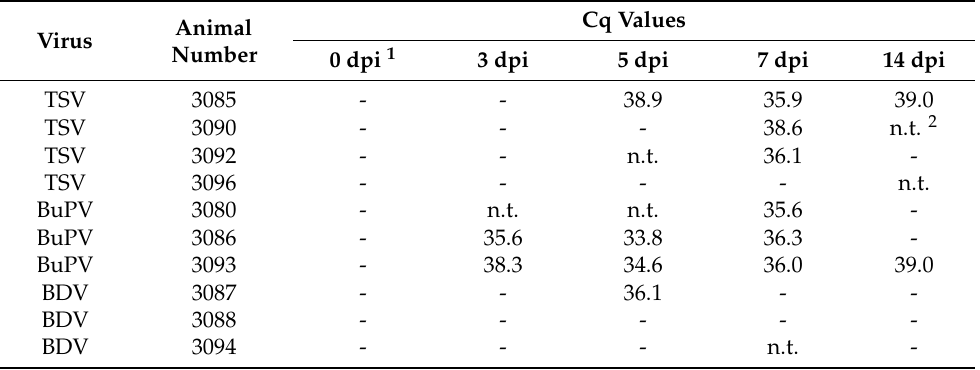
Table 1. Detection of viral RNA by real-time RT-PCR in serum samples of piglets at different days after infection with the indicated viruses.